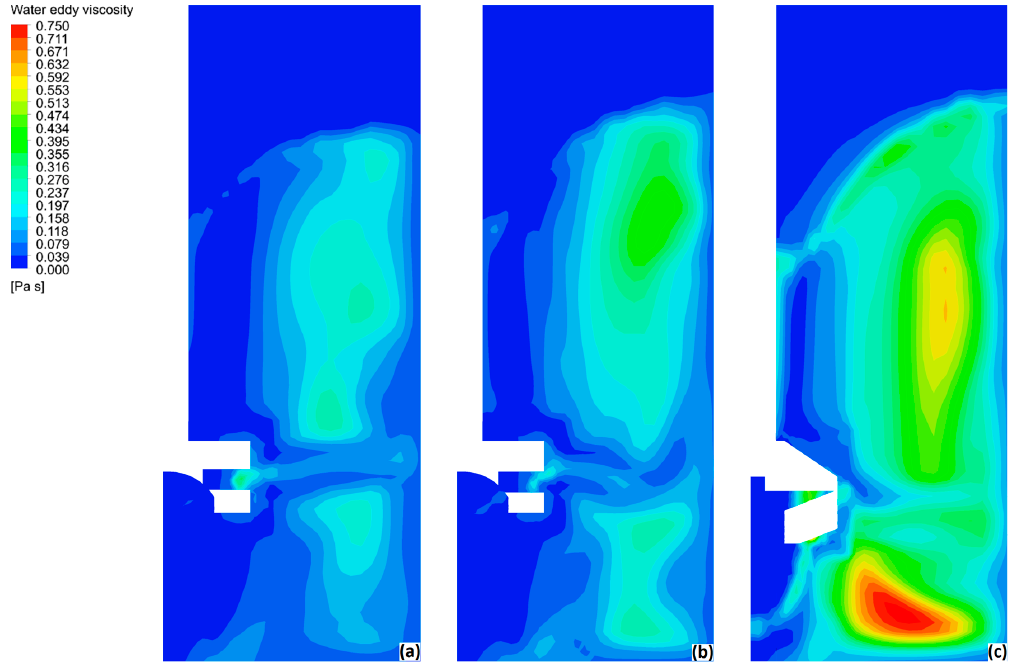
Figure 9. Water eddy viscosity fields in the r-z plane of the ladle for the three impellers tested at 400 rpm and 10 L/min. ( a ) Impeller A; ( b ) impeller B; ( c ) impeller C.